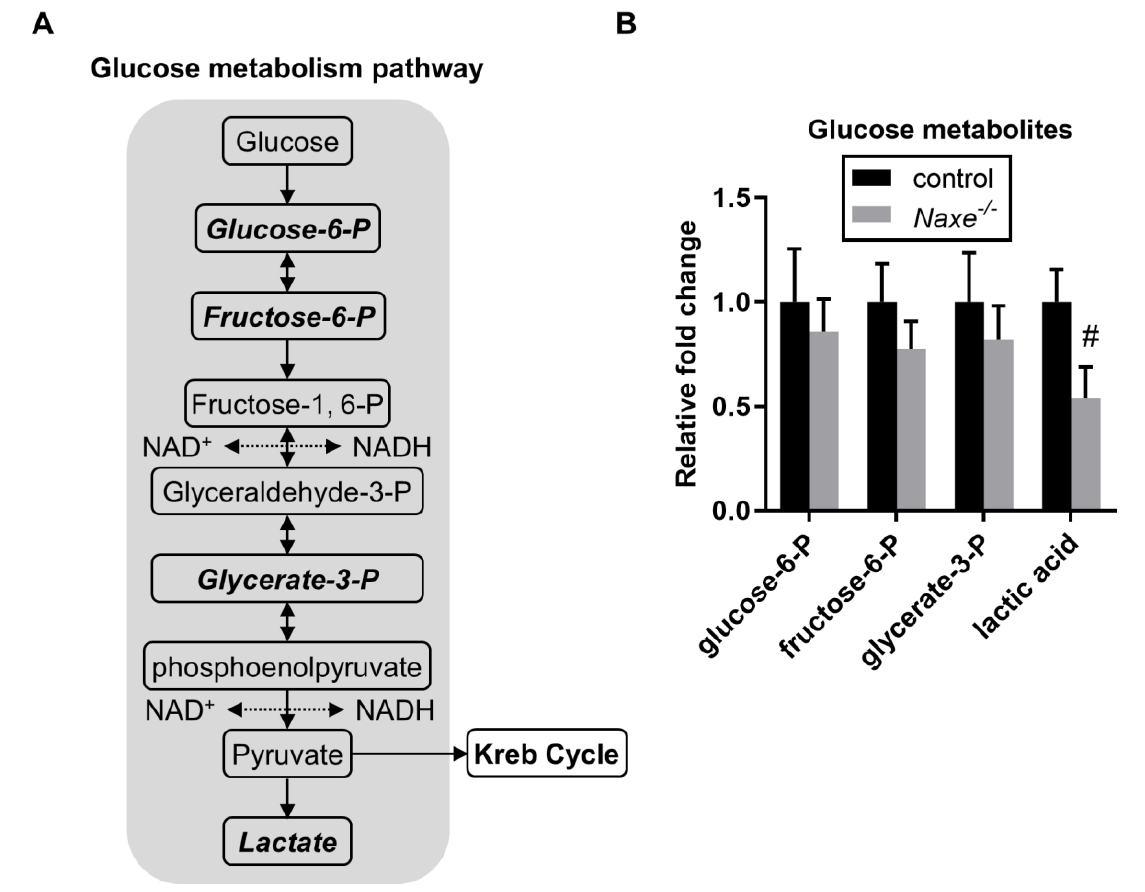
Figure 4. Effect of NAXE deletion on glucose metabolism. ( A ) Scheme depicting the glucose metabolism pathway. ( B ) Relative abundance of detected glucose metabolites. Mean±SE; # p = 0.057; n = 6 mice per group. Detected metabolites are indicated in bold and italic letters.